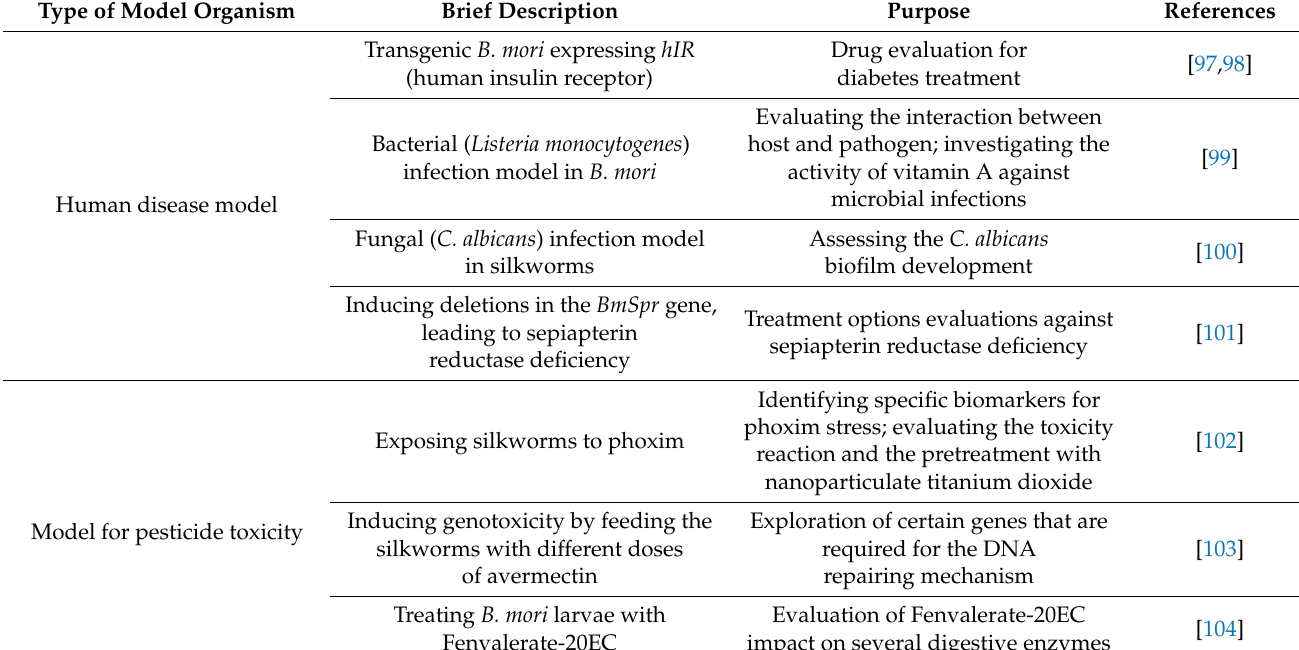
Table 2. Summary of various uses of B. mori as an experimental model